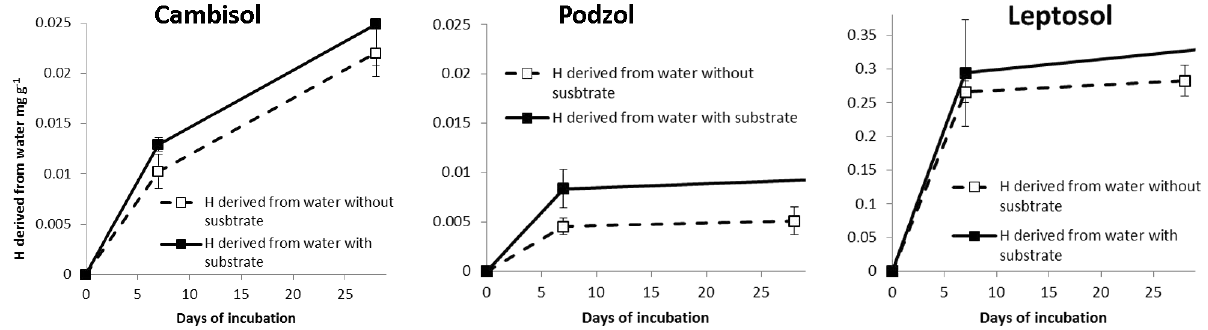
Figure 3. Concentration of non-exchangeable hydrogen derived from water with and without addition of substrate in the total soil for the Cambisol, Podzol and Leptosol from 0 to 28 days of incubation. Note that the scale of y axis is different for the three soils.